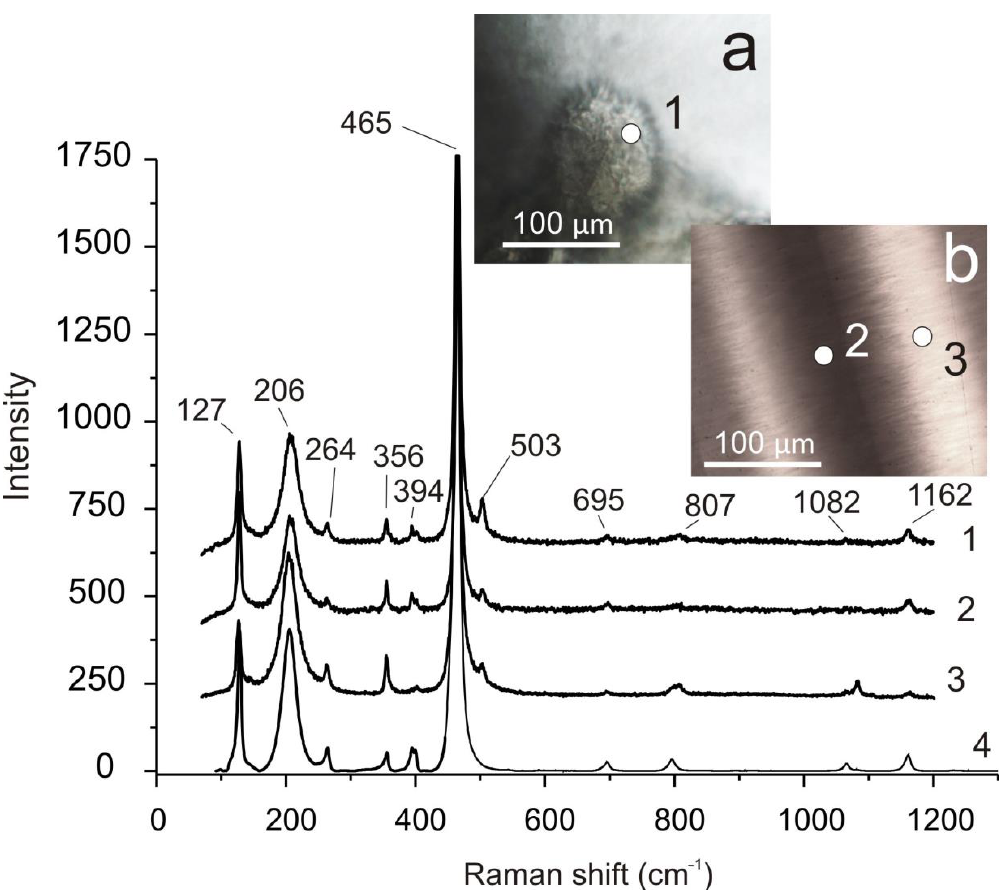
Figure 11. Raman spectra of agate No. 4 (Figure 4b,e) have been taken at various exposure points (1–3) shown in the micrographs ( a , b ) that were taken in transmitted light. Spectrum 1 is from a semitransparent globule ( a ) located on the periphery of “moss” aggregates. The micrograph b and spectras 2 and 3 are the respective translucent and transparent layers at the center of the nodule. The most intense quartz and moganite bands are shown at 465 and 503 cm − 1 , respectively. All other bands are quartz signals. Spectrum 4 is quartz (X080016) from the RRUFF database [39].